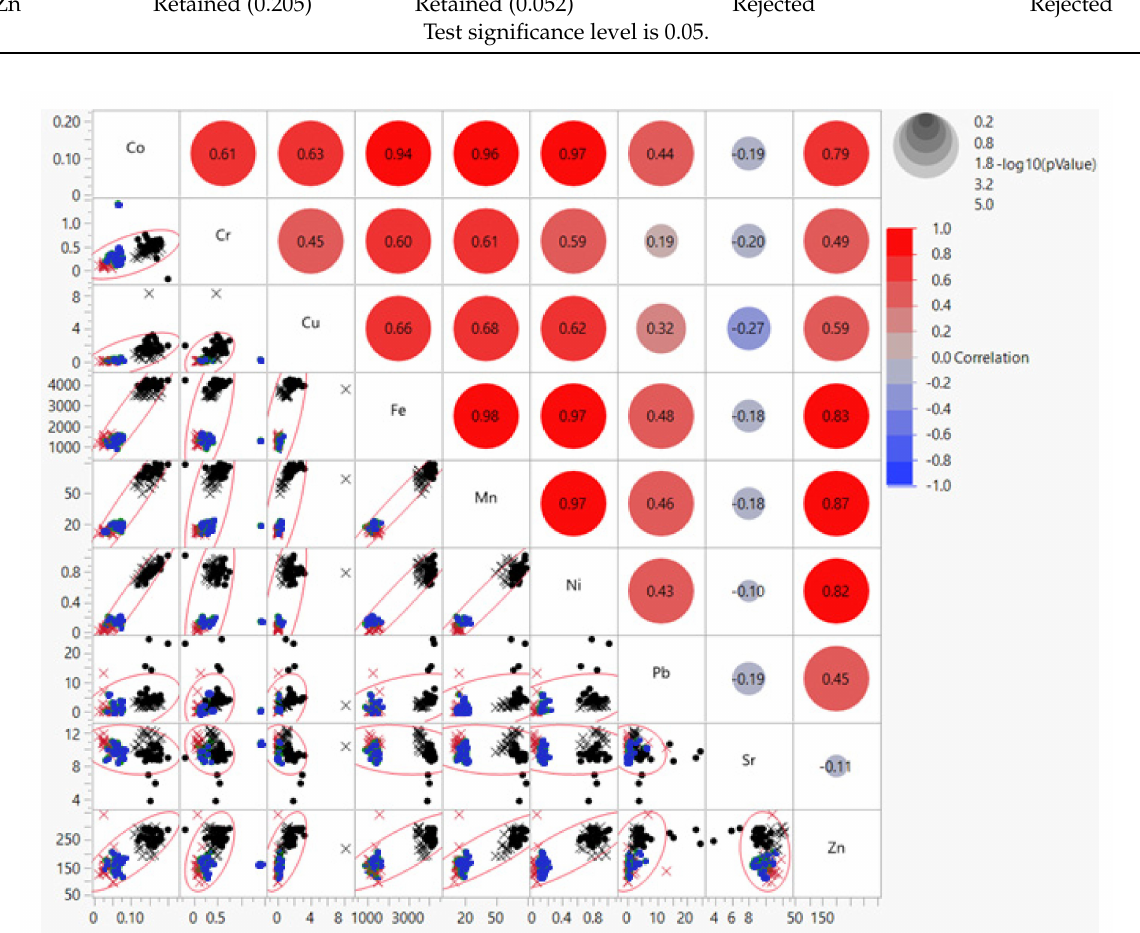
Figure 1. Scatter plot on multivariate correlations—Pre-harvesting and Post-harvesting stages. (Key: × represents data from Field A pre-harvesting stage; • represents data from Field B pre-harvesting stage; × represents data from Field A post-harvesting stage; • represents data from Field B post- harvesting